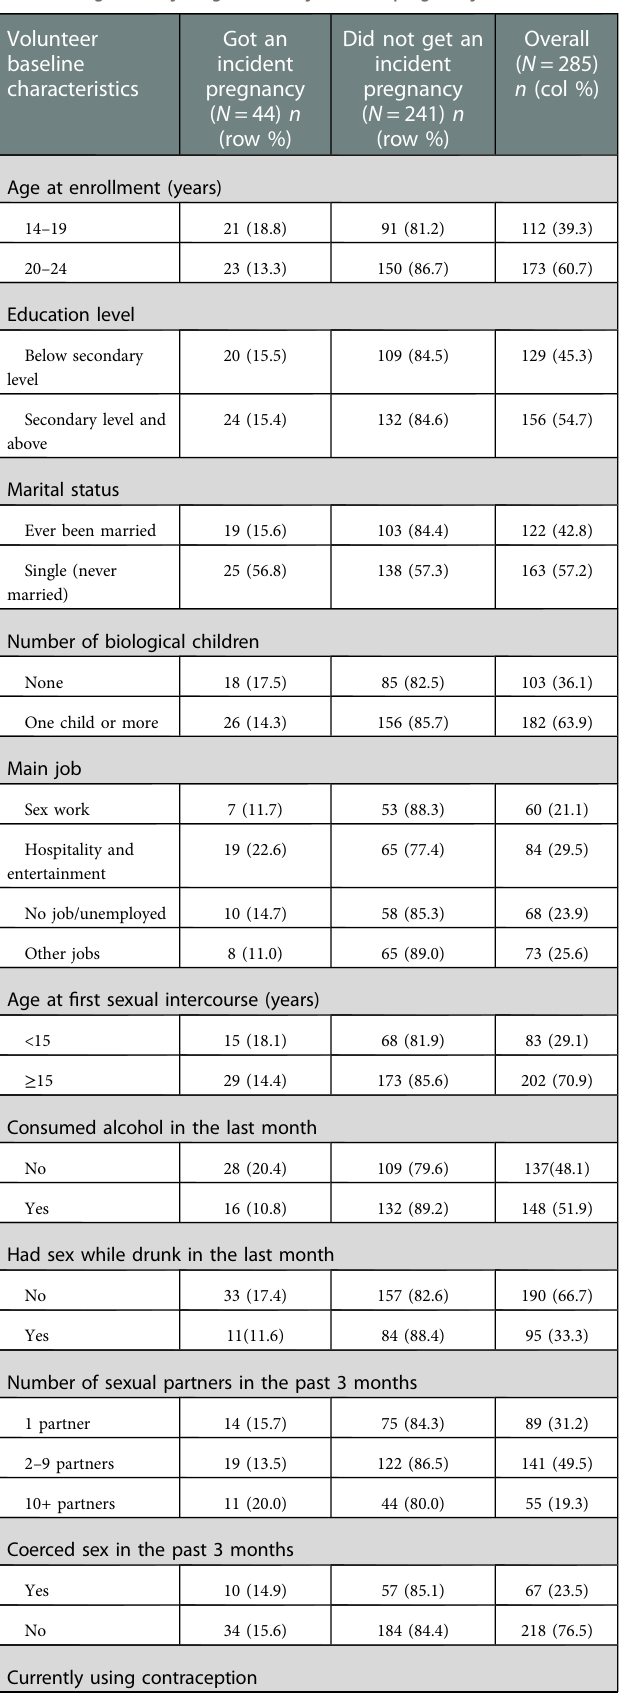
TABLE 1 Baseline sociodemographic and behavioral characteristics of adolescent girls and young women by incident pregnancy